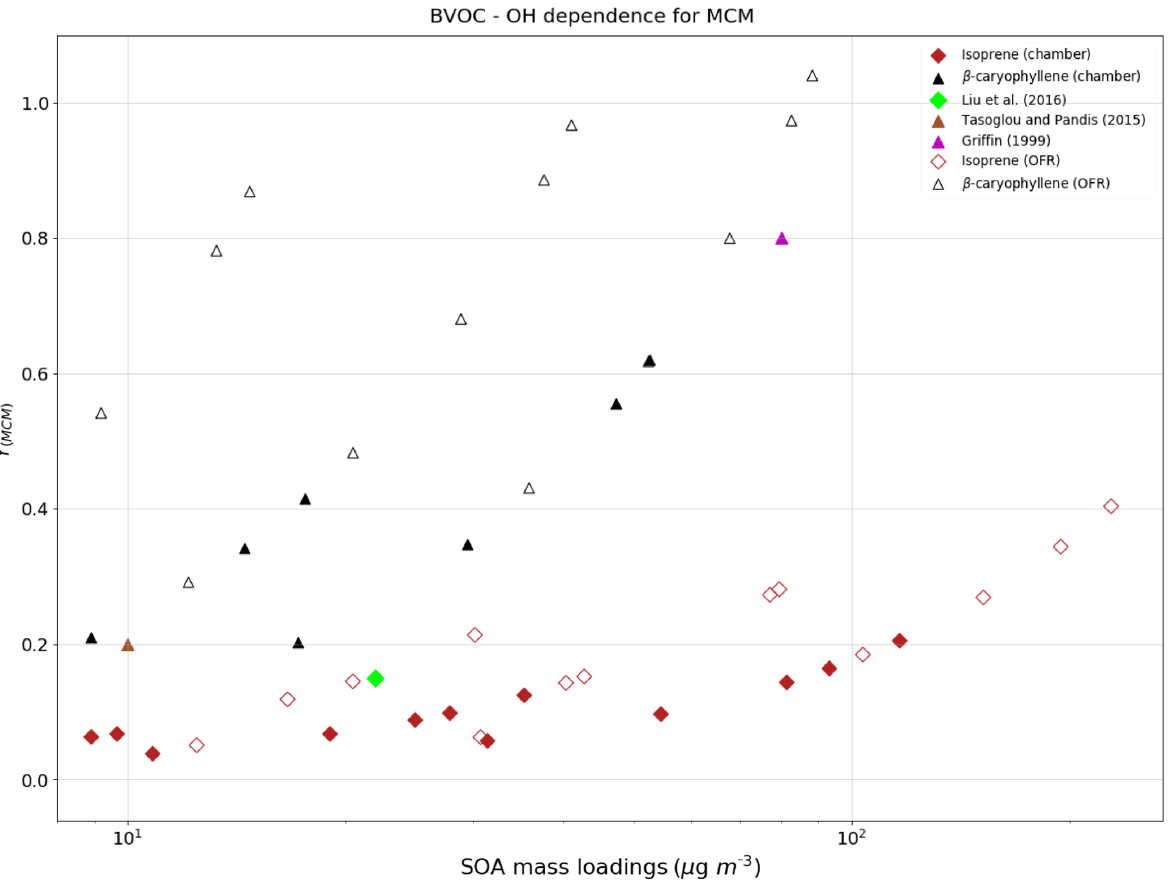
Figure 4. The mass yields from OH oxidation of BVOCs β -caryophyllene (black triangles) and isoprene (maroon diamonds) modeled after chamber (filled symbols) and flow-tube settings (open symbols). The figure shows a comparison of SOA mass yields obtained from application of MCM as currently there is no PRAM available for these